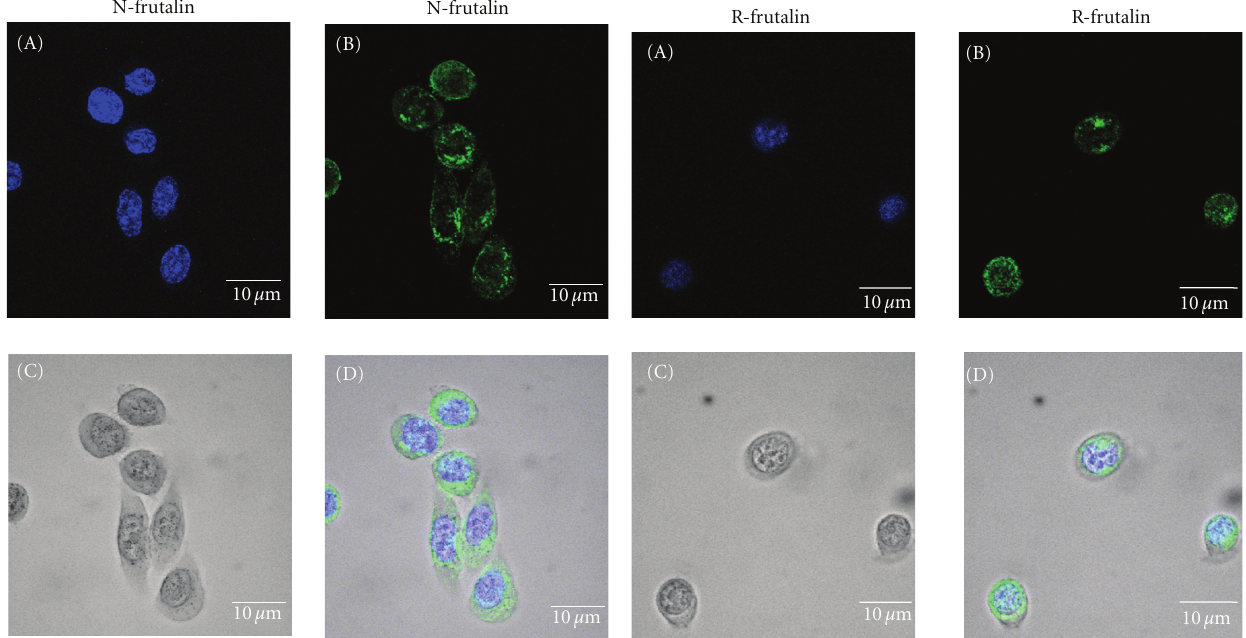
Figure 6: Localisation of n-frutalin and r-frutalin in HeLa cells by fluorescence confocal microscopy. Representative projections for the cellular localisation of each frutalin form in HeLa cells 1 h after incubation at 37 ◦ C are shown: n-frutalin – projection of 38 slices of 50 in the total; r-frutalin—projection of 13 slices of 25 in the total. Legend: (A) nuclear staining with DAPI; (B) lectin staining with FITC; (C) bright field; (D) merged